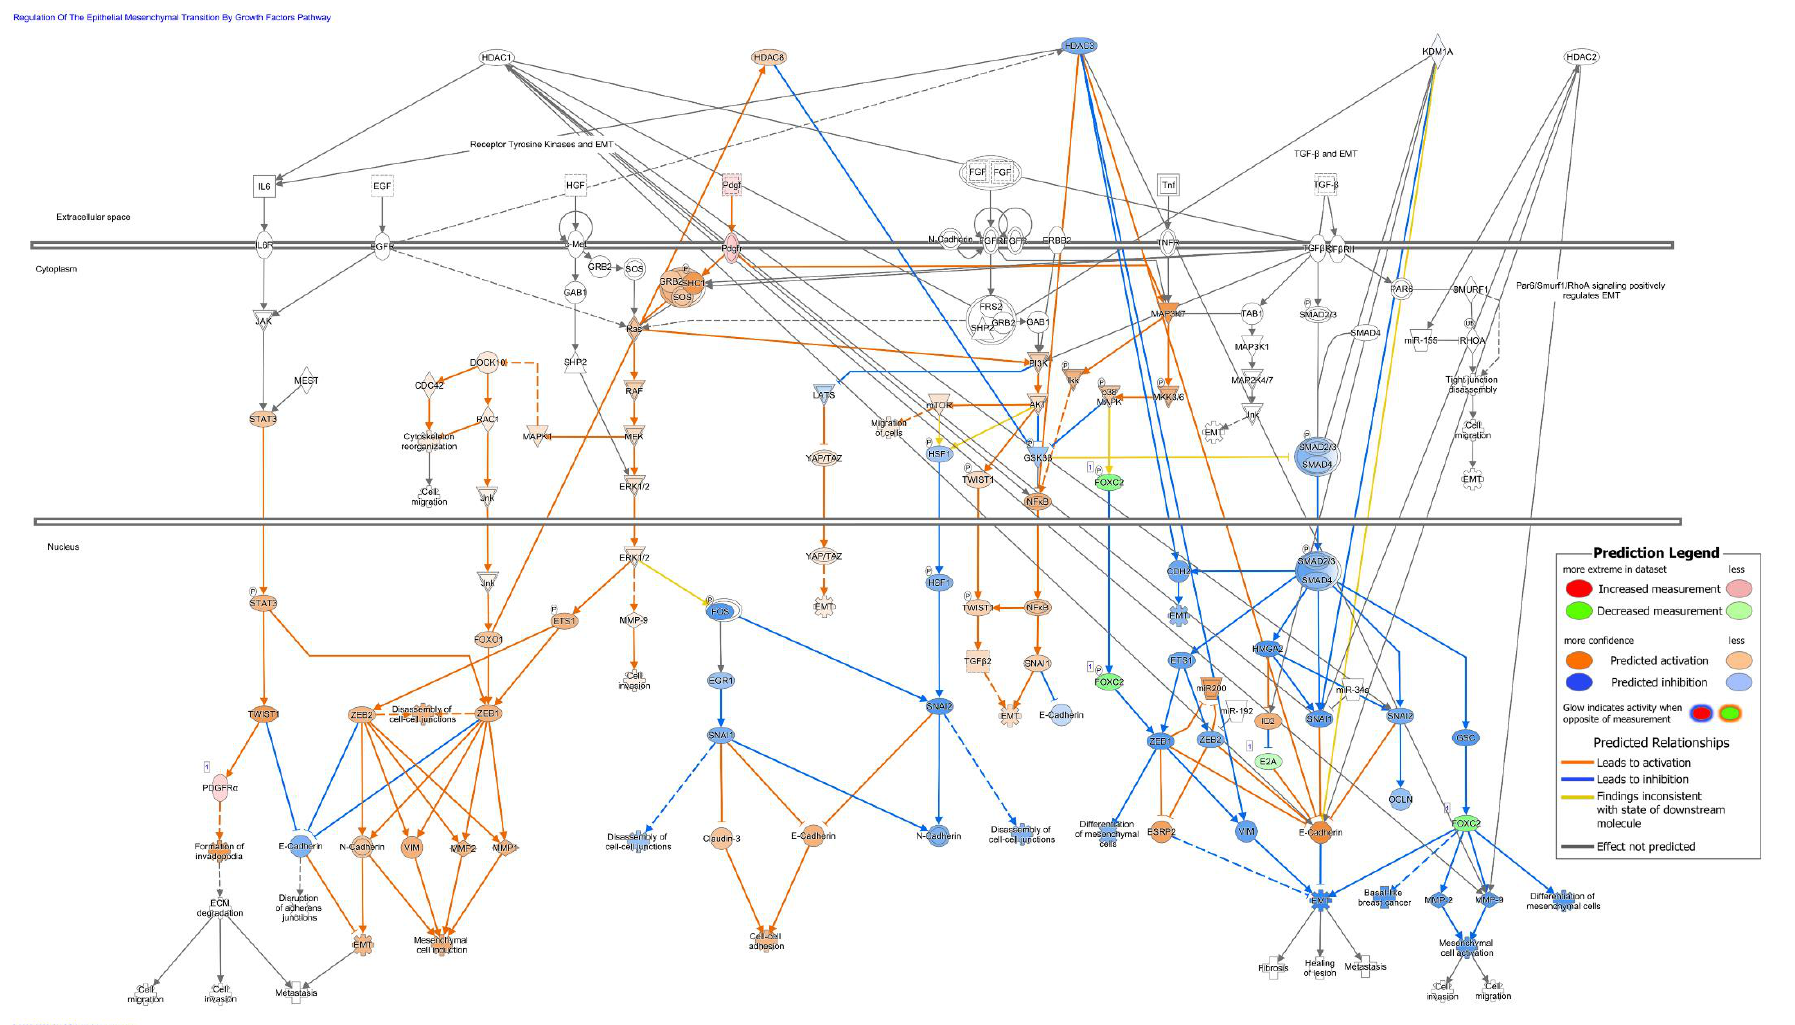
Figure 8. IPA-predicted activation and inhibition of the enriched regulation of epithelial mesenchymal transition by the growth factors pathway based on 4SC-202-induced consensus DEGs. The pathway is built in Ingenuity Pathway Analysis (IPA) and illustrates the known molecular relationships. The molecules